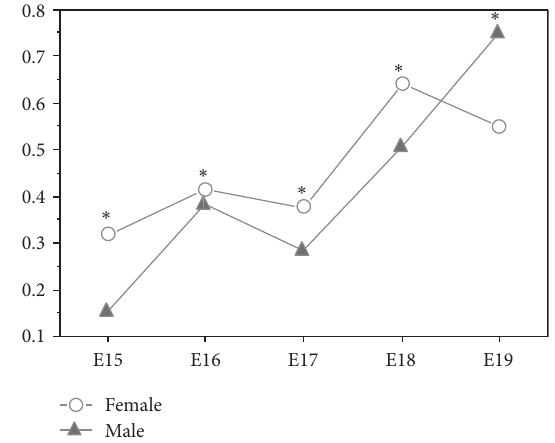
F 5: Lung retinyl palmitate in the male of control (Mc) and vitamin A (Ma) groups (ng/ g protein), from developmental days g protein), from developmental days E15 statistically E15 to E19 ( 0.003 and SE ; 𝜇𝜇 ∗ 𝜇𝜇 ∗ 𝑃𝑃 𝑃 0.0001 𝑃𝑃 𝑃 0.0001 ≤ = 0.001